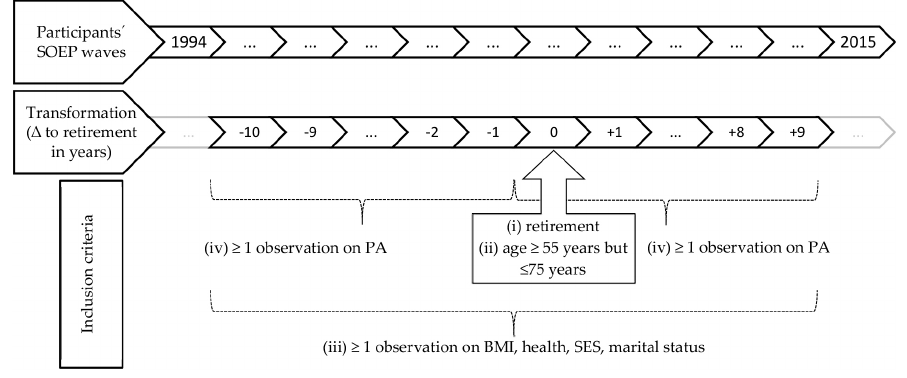
Figure 1. Sampling strategy with inclusion criteria (i) to (iv). Socio-Economic Panel Study (SOEP), physical activity (PA), socioeconomic status (SES), body mass index